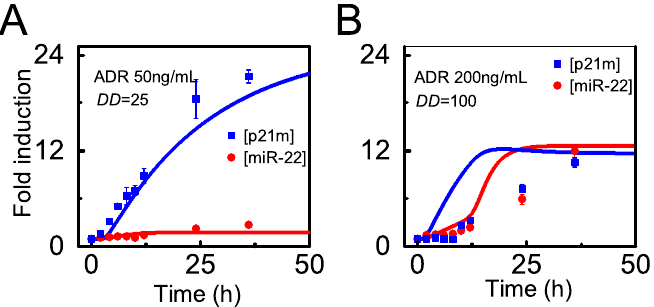
Figure 5. Time courses of p21 mRNA and miR-22 under two distinct conditions. Time courses of [p21m] ( p21 mRNA, blue) and [miR-22] (red) upon moderate ( A ) or severe ( B ) damage based on the simulation results (line) or normalized experimental data (dot) retrieved from Ref.